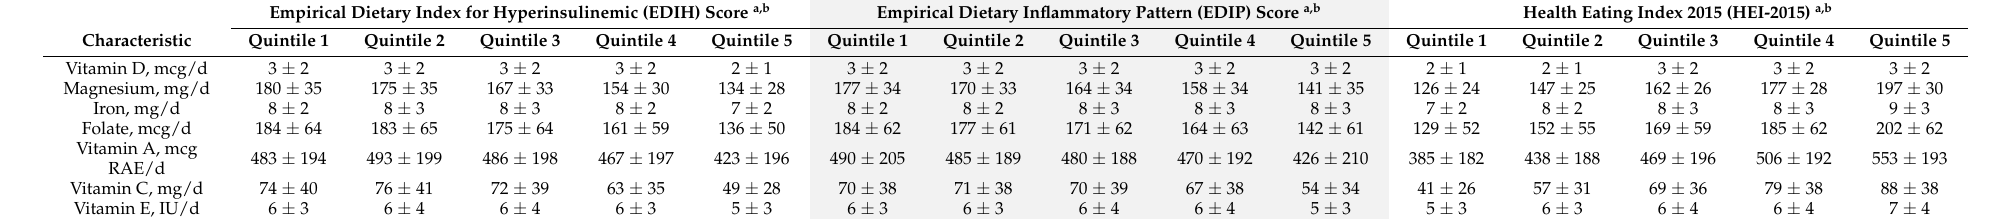
Empirical Dietary Index for Hyperinsulinemic (EDIH) Score a,b Empirical Dietary Inflammatory Pattern (EDIP) Score a,b Health Eating Index 2015 (HEI-2015) a,b